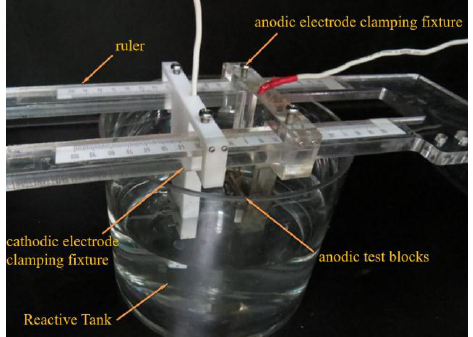
Figure 1. The actual plasma electrolytic reaction system.